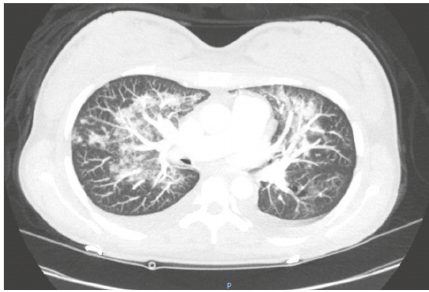
Figure 3: Repeat chest computed tomography angiography (CTA) on hospital day 5 featuring progressive ground-glass opacities bilaterally, which, in the setting of continued hemoptysis, was concerning for diffuse alveolar hemorrhage.